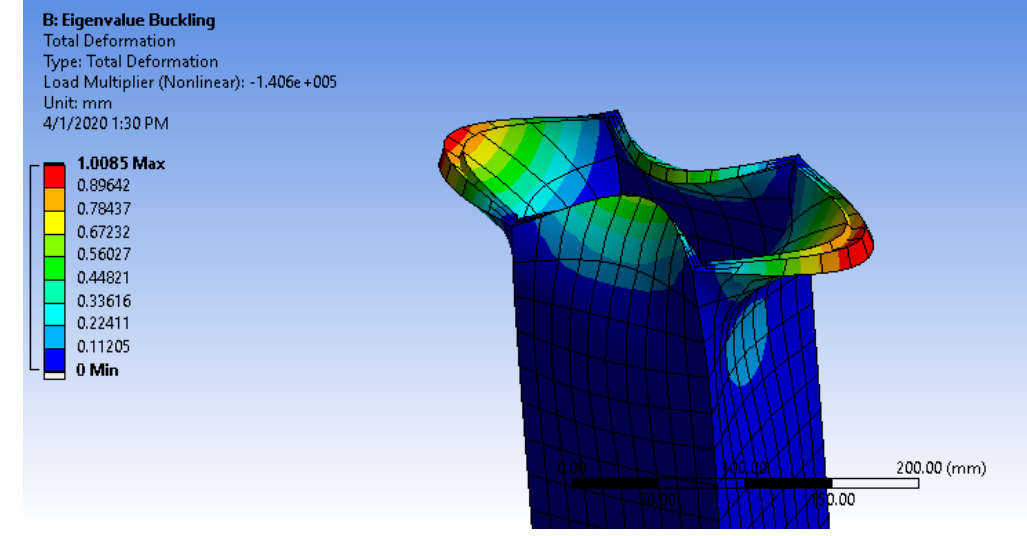
Figure 16. Local buckling of GRCCs occurs when the high-density polyethylene (HDPE) sleeve cannot provide sufficient stiffness to prevent the glass from locally buckling at the point of loading.